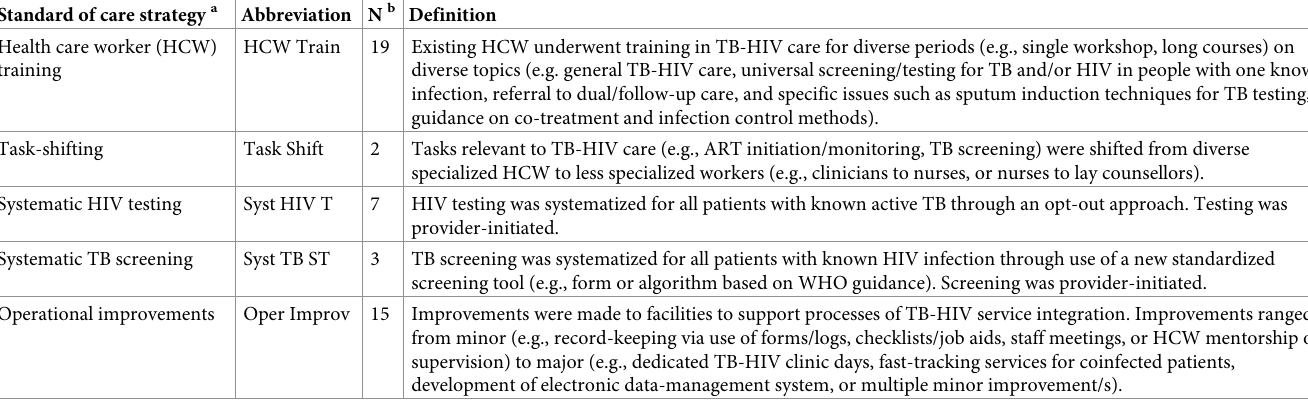
Table 4. Definitions of standard of care strategies implemented as co-interventions. Standard of care strategy a Abbreviation N b